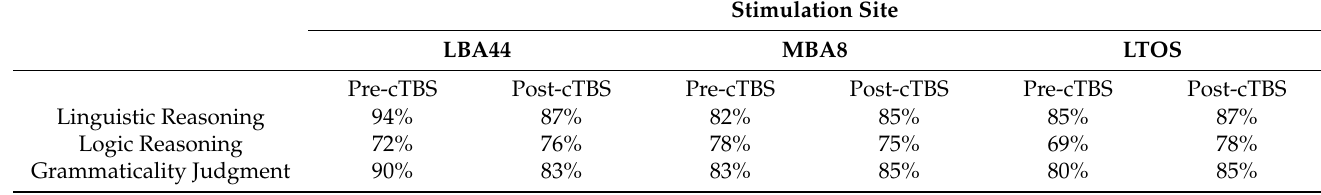
Table 2. Mean accuracy for each task before (Pre-cTBS) and after (Post-cTBS) transient inhibitory stimulation to each site.